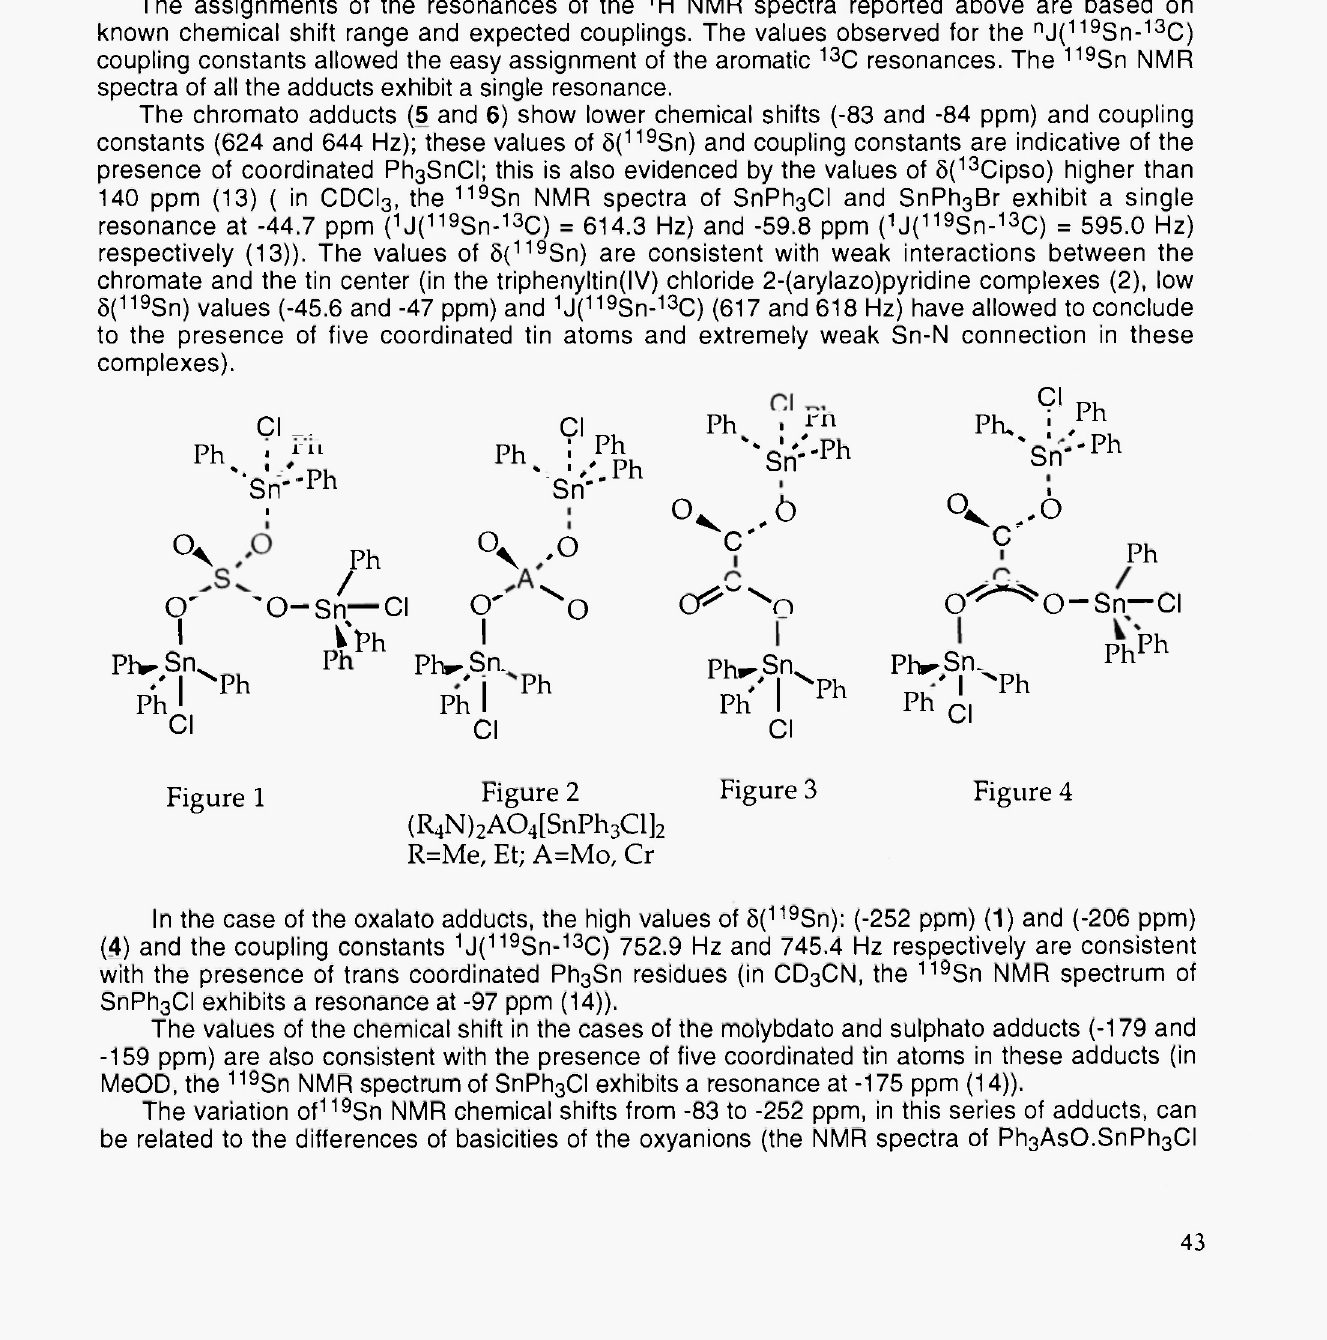
(R N) A0 [SnPh 4 2 4 R=Me, Et; A=Mo,